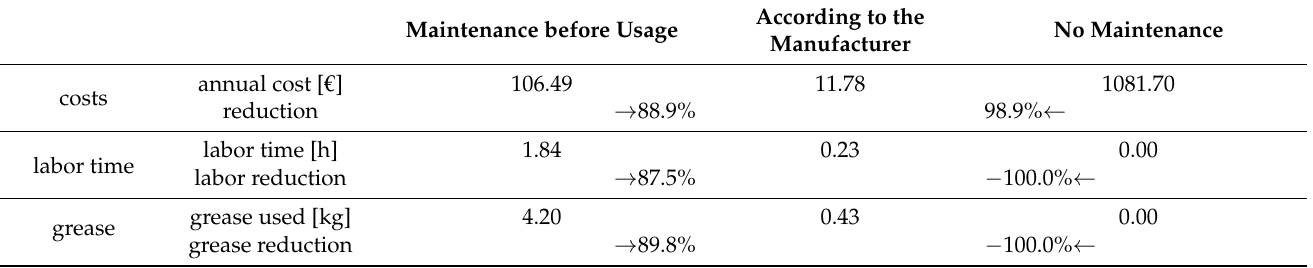
Table 4. Reduction of costs, labor time and grease for the large baler from the extreme scenarios to when maintenance is carried out as specified by the